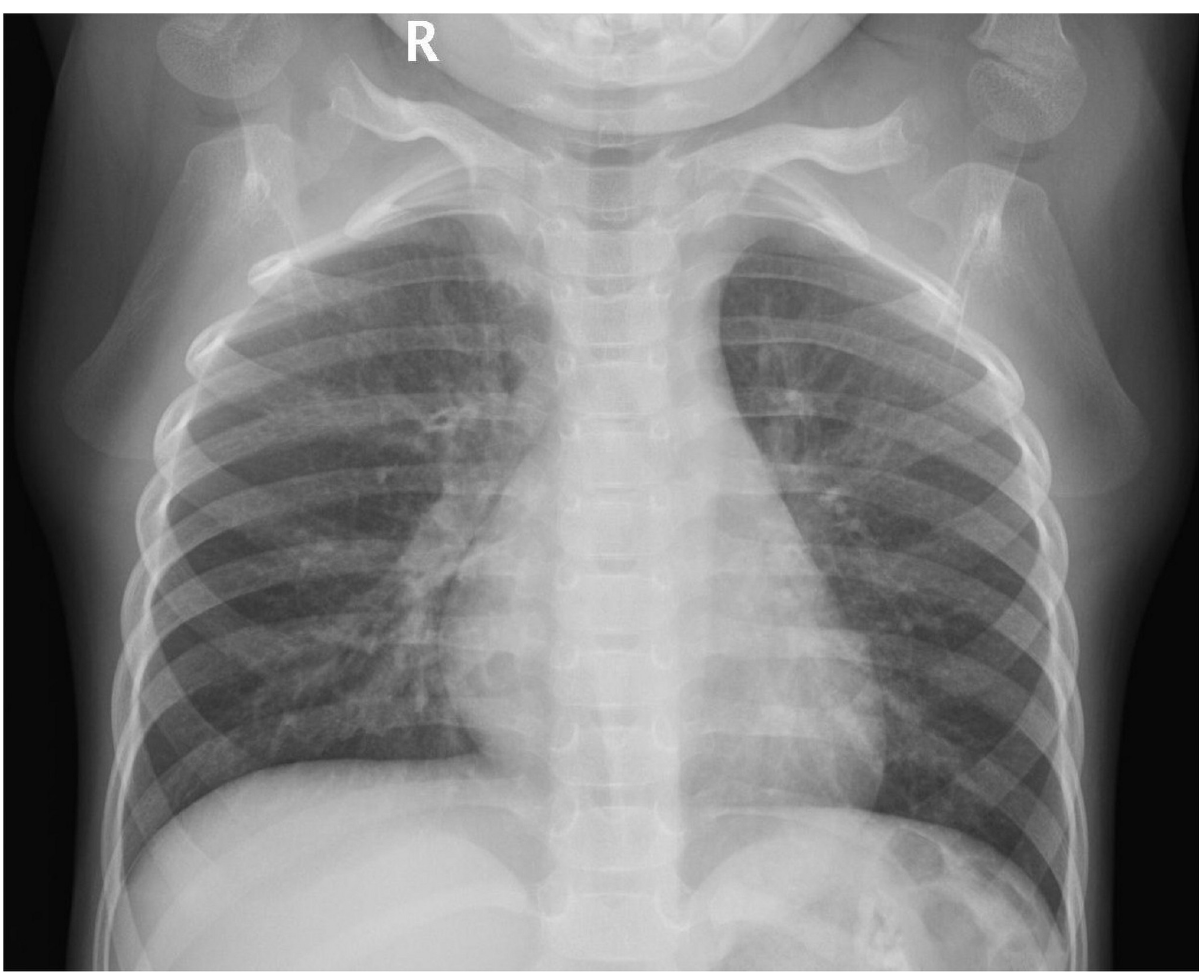
Fig 5. Chest DR image of a pediatric participant in the supine APP group (unit A). The image shown is that of a 38-month-old female with a height of 109 cm, a weight of 15 kg, and a BMI of 12.63 kg/m 2 . The ESD value was 0.07 mGy, the DAP value was 0.22 dGy•cm 2 , the VGAS was 29, the right LFA was 64.80 cm 2 , the left LFA was 50.50 cm 2 , the total LFA was 115.30 cm 2 , and the LD was 11.50